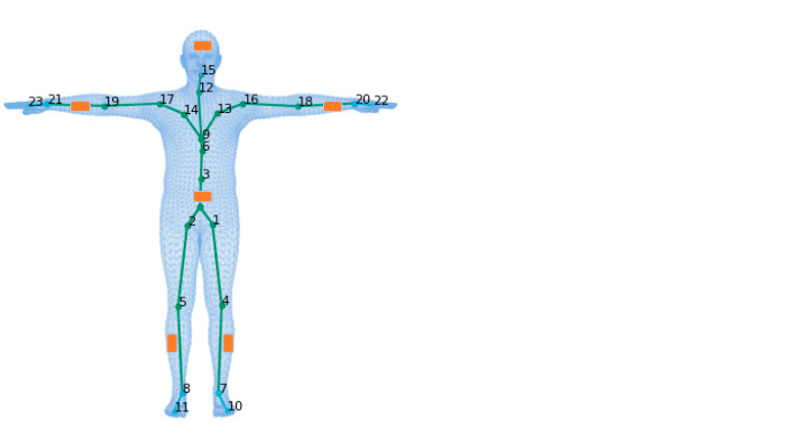
Figure 2. Illustration of the mesh, skeleton, and joints with the T-pose template. The line plot is a common kinematic representation of the human body by 24 key points. The triangle mesh is the skinned and vertex-based three-dimensional prior model in the SMPL. The placement of six IMUs in this study is indicated in